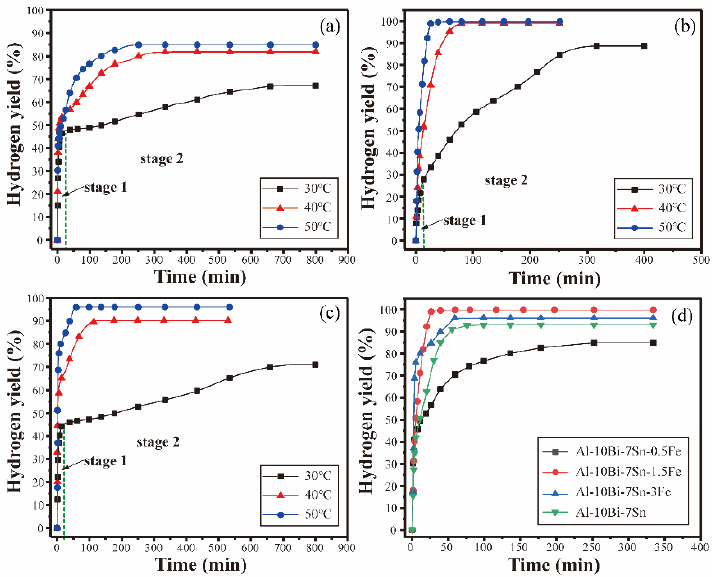
Figure 6. Hydrogen generation curves of the Al-Bi-Sn-Fe composite powders reacting with distilled water at 50 °C. ( a ) Al-10Bi-7Sn-0.5Fe (wt.%); ( b ) Al-10Bi-7Sn-1.5Fe (wt.%); ( c ) Al-10Bi-7Sn-3Fe (wt.%); ( d ) Al-10Bi-7Sn-xFe (x = 0, 0.5, 1.5, 3) (wt.%) composite powders [33]. The hydrogen generation properties of the Al-10Bi-7Sn-0.5Fe (wt.%) composite